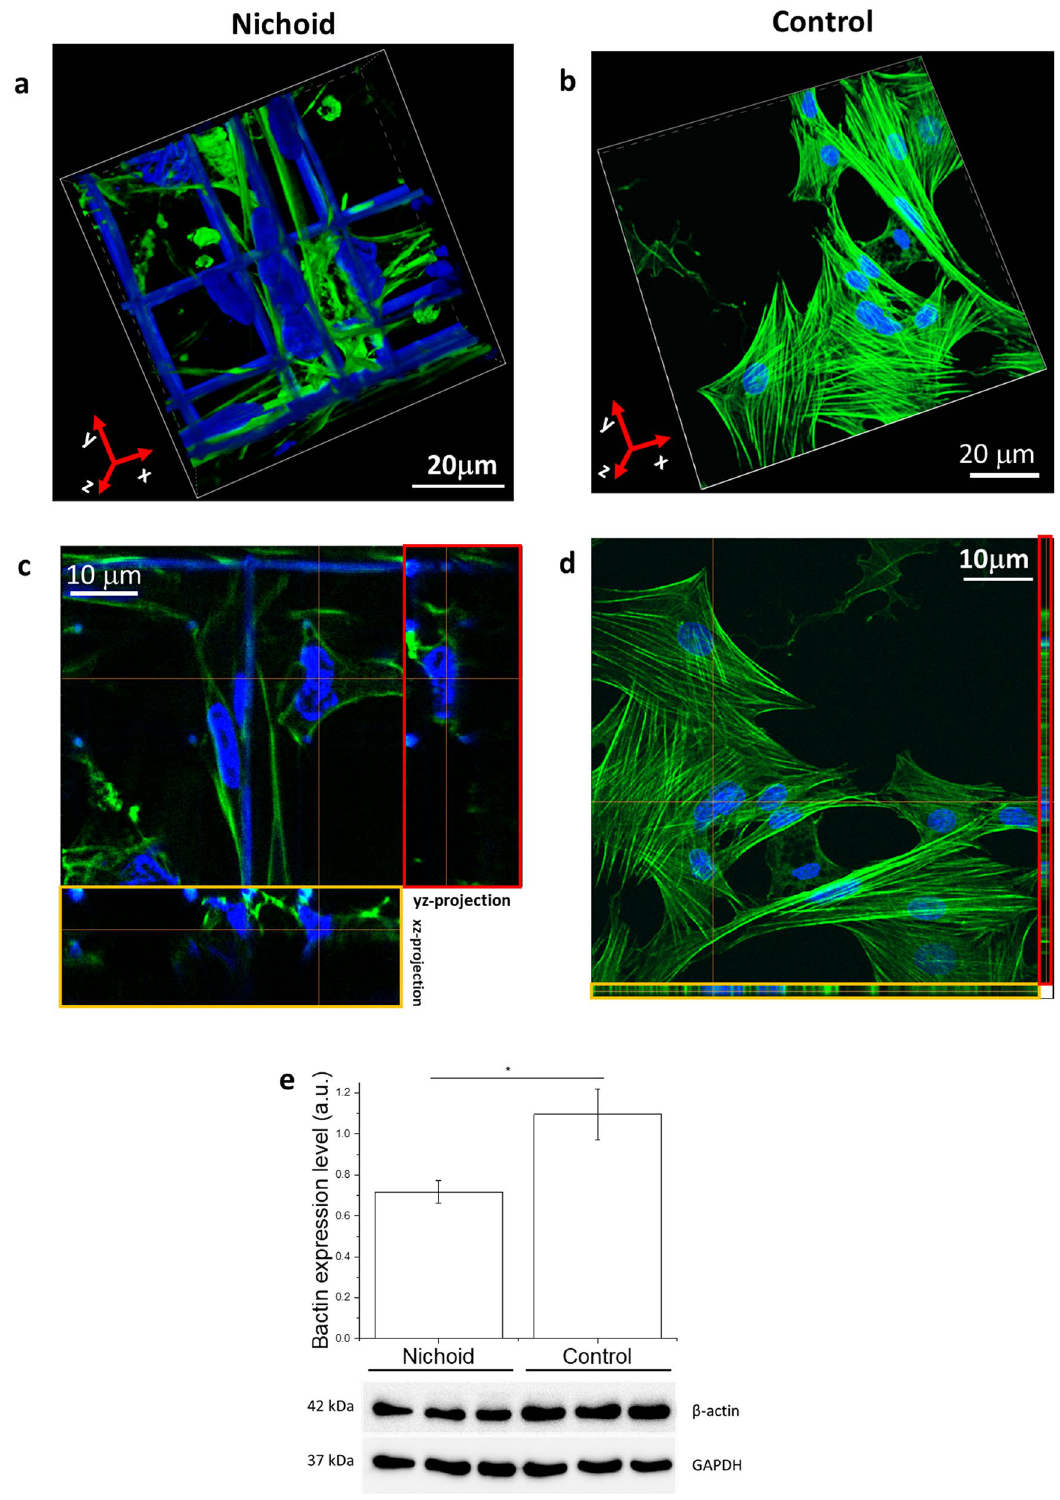
Figure 2. Spatial organization of actin filaments in MSCs adhering to the Nichoid artificial niche. ( a,b ) 3D reconstruction from confocal acquisitions of cells grown into the Nichoid ( a ) and on the Control ( b ). In green are identified actin fibers and in blue the cell nuclei. The SZ2080 photopolymer, used to fabricate the niche, is fluorescent at all excitation wavelengths, including at 405 nm that is the excitation wavelength of the fluorescent dye used to label the nuclear DNA. ( c,d ) Orthogonal (yellow ROIs) and sagittal (red ROIs) projections of MSCs grown into the Nichoid ( c ) and on a flat control substrate ( d ). ( e ) Actin expression level calculated by western blot. Statistics: Mann–Whitney test. *Corresponds to p <